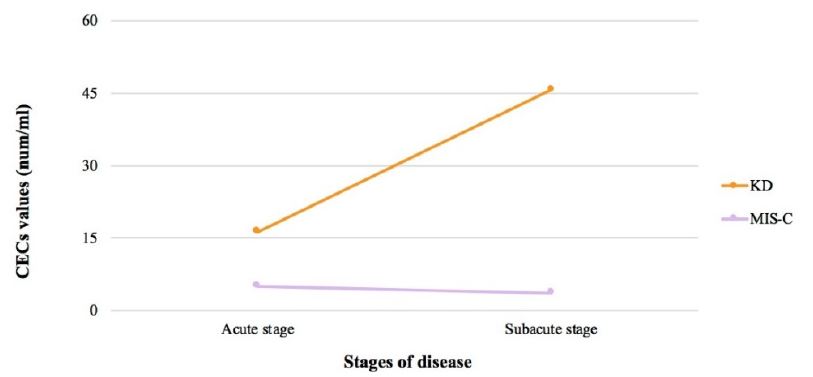
Figure 2. CECs trend from acute to subacute stage, in KD and MIS ‐ C patients. KD stands for Kawasaki Disease; MIS ‐ C stands for Multisystem Inflammatory Syndrome in Children; CECs stands for circulating endothelial cells.